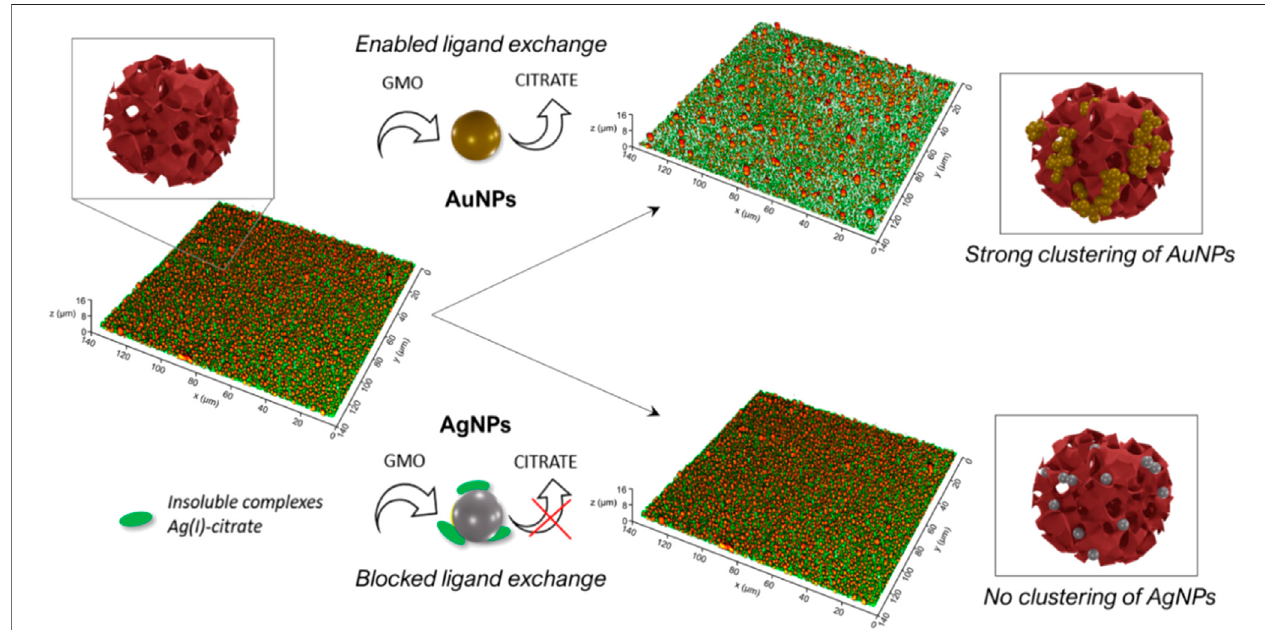
FIGURE8| Schematicrepresentation ofthemechanismand fi naloutcomes oftheinteractionofAuNPsand AgNPswithawaterdispersion cubosomesand solid- supported fi lms of cubosomes.